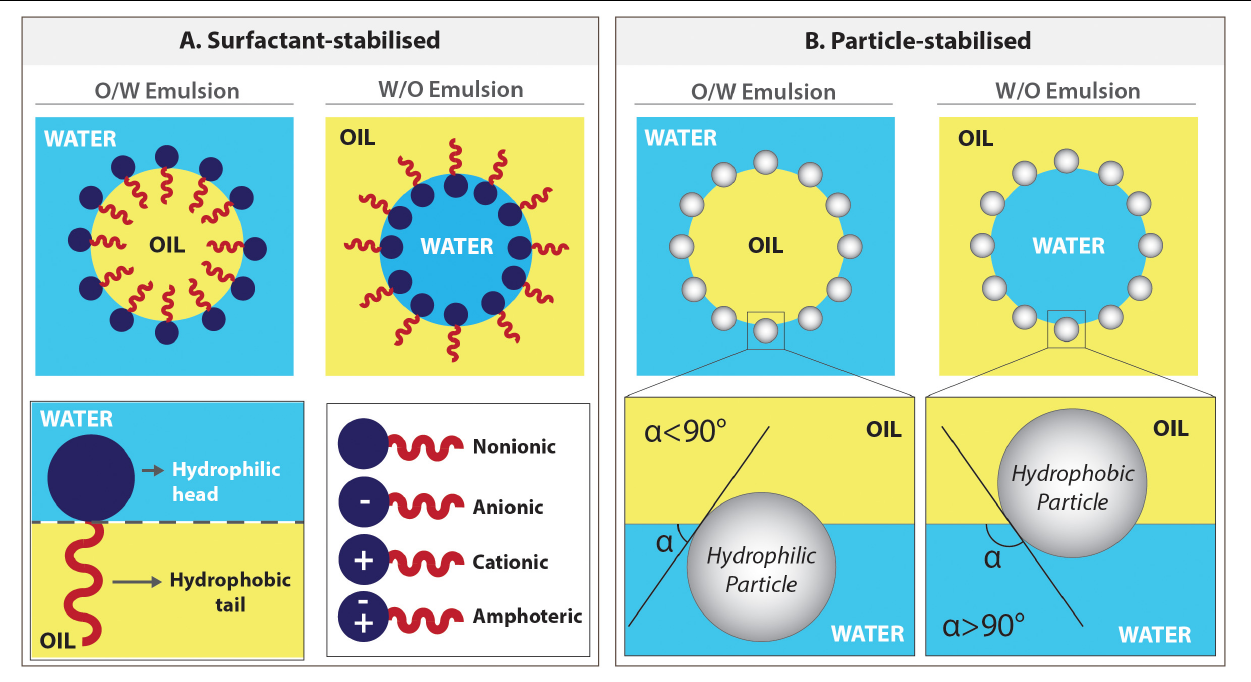
FIGURE 8 | Emulsions can be stabilised either by surfactants or particles. (A) The positioning of the surfactant molecules in o/w and w/o emulsions and types of surfactants. (B) The positioning of the particles on the water–oil interface of either in o/w or w/o emulsions depending on the degree of wettability of the particles by these